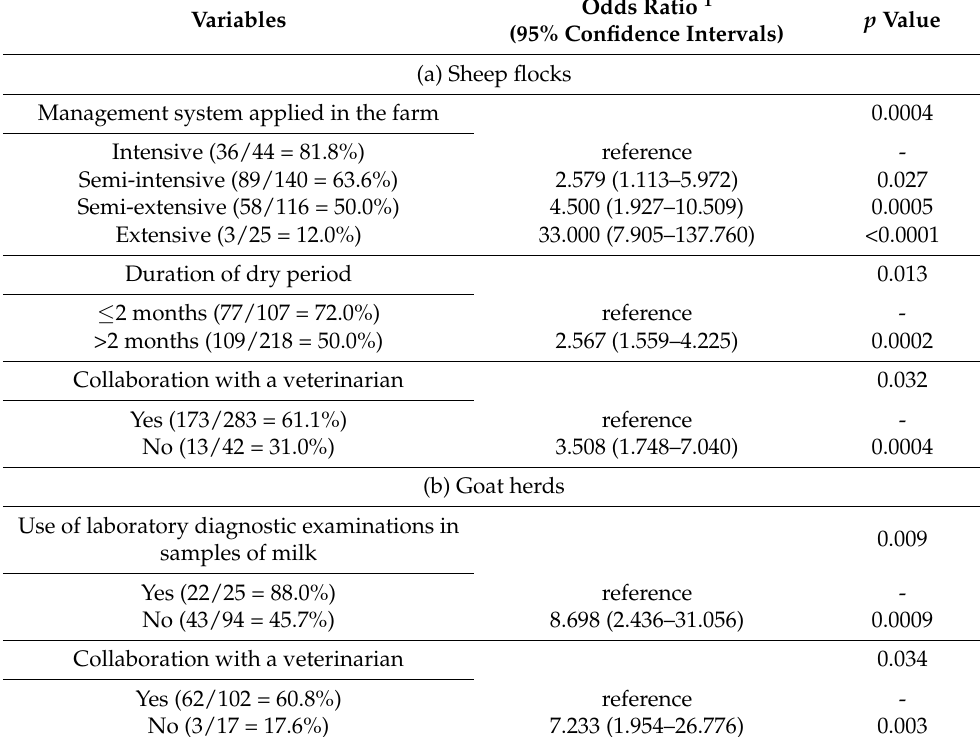
Table A3. Multivariable analysis for variables associated with optional vaccination against contagious agalactia in 444 small ruminant farms in